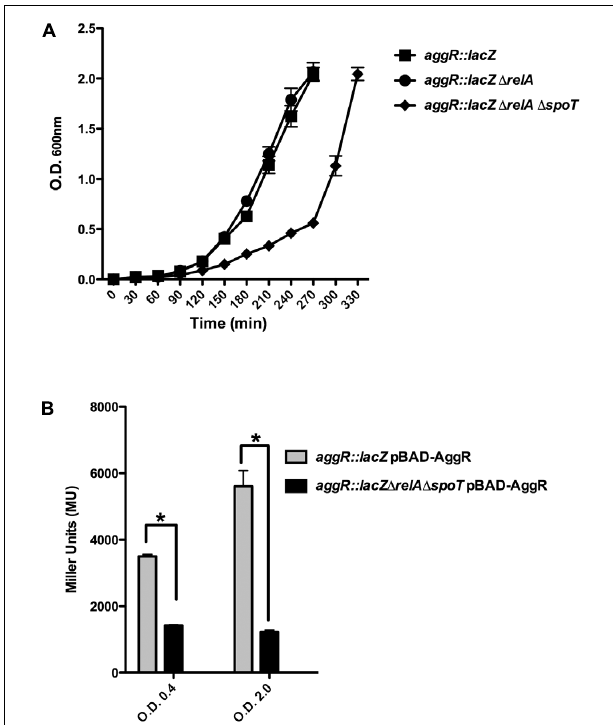
FIGURE 2 | Expression of aggR is reduced in a (p)ppGpp 0 derivative of strain 042. (A) Impact on growth rate of the relA and relA spoT derivatives of strain 042LCaggRlacZ. Growth curves of strains 042 aggR::lacZ, 042 aggR::lacZ (cid:49) relA and aggR::lacZ (cid:49) relA (cid:49) spoT . Growth kinetics of the WT 042 strain (not shown) was identical to that of the 042 aggR::lacZ strain. (B) β -Galactosidase activity of strains 042LCaggRLacZ (pBAD-AggR) and 042LCaggRlacZrel AspoT (pBAD-AggR) grown at 37 ◦ C in LB medium with 0.45% of L -arabinose either to the exponential or to the early stationary growth phases. The data shown are the means and standard deviations of three independent experiments. Statistical analysis showed significant differences compared to the control ( ∗ P -value < 0.0001).